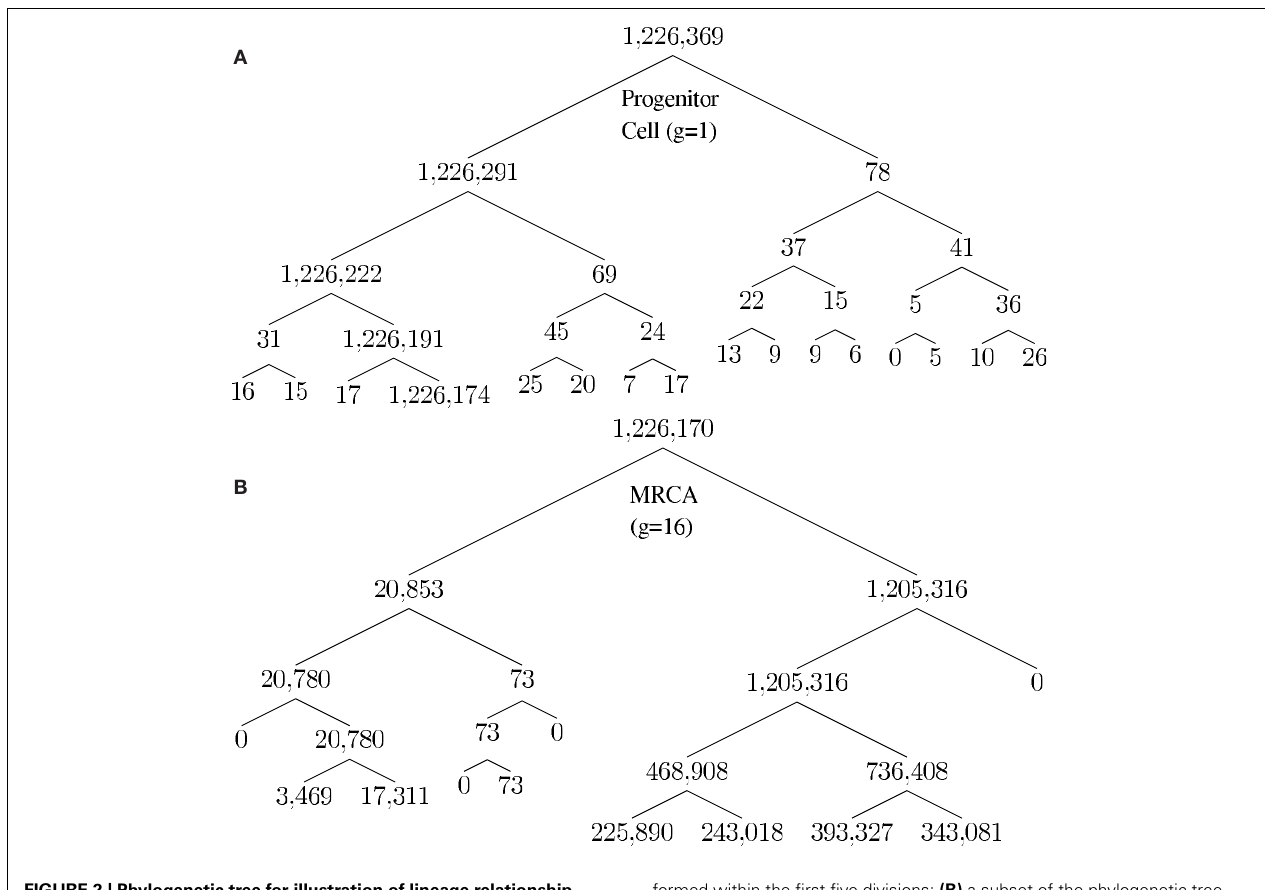
FIGURE 2 | Phylogenetic tree for illustration of lineage relationship during the earliest stage of oncogenesis. The number indicates the size of descendants in the tumor from the cells (nodes). (A) The lineage map